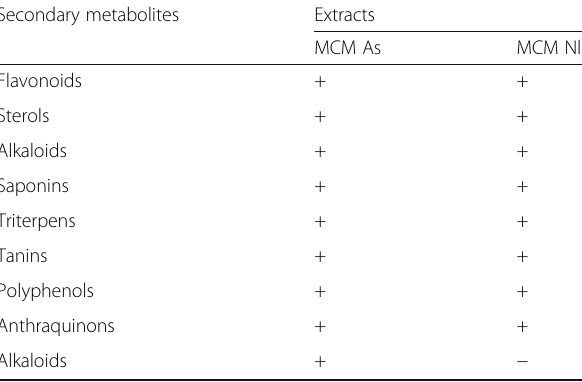
Table 5 Secondary metabolites presents in Methylene Chloride-